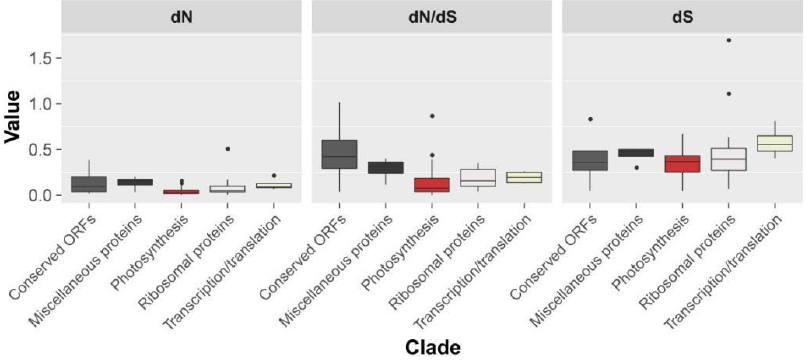
Figure 7. The mode and strength of selection among 77 chloroplast protein-coding genes in Dalbergia